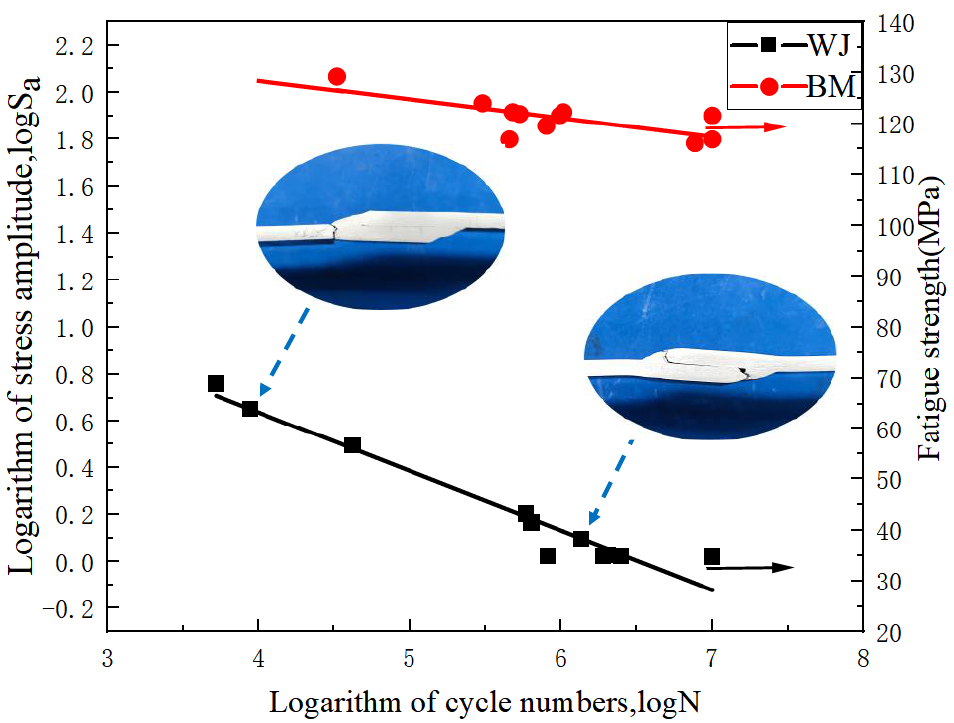
Figure 5. S-N fatigue curve of base metal and welded joint.